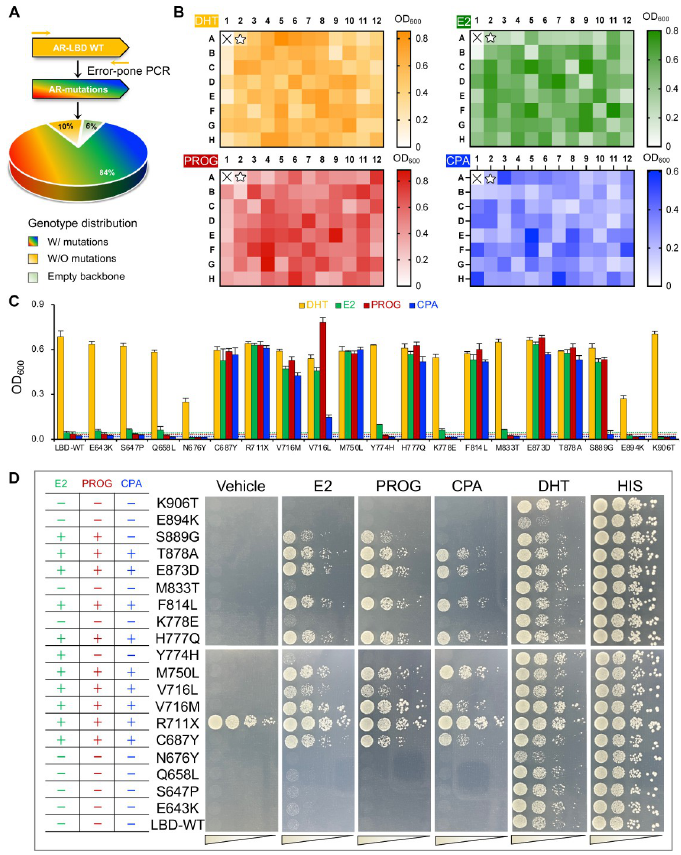
Fig 3. Simulation of AR evolution by combining designer yeast with random mutagenesis. ( A ) Characterization of the AR-LBD EP-PCR library. ( B ) Yeast clonal selection against compounds based on solid culture in 96-well plates without the presence of 3-AT. Ligands were 10 − 8 M DHT, 10 − 5 M PROG, 10 − 5 M E2, and 10 − 5 M CPA. The heatmap represents OD 600 values of liquid cultures measured 21 h post-incubation. LBD-WT is indicated by pentacles; the × mark indicates blank wells. ( C - D )Functional analysis of 19 identified AR mutations using both liquid (n = 6) and plate yeast assay in the presence of 3-AT against DHT 2 μ M, E2 2 μ M, PROG 2 μ M, and CPA 2 μ M. The incubation time was 60 h. Bars indicate mean ± s.d.